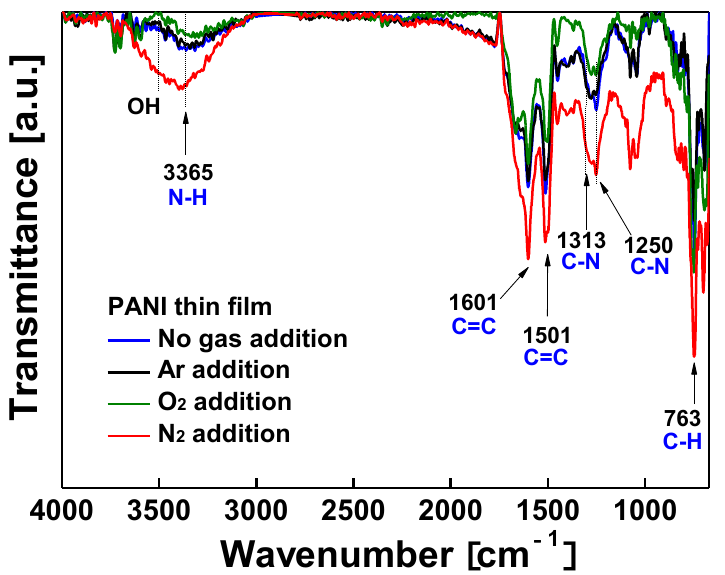
Figure 6. 2D and 3D AFM images with the roughness of PANI films prepared ( a ) without auxiliary gas, ( b ) with the addition of Ar, ( c ) O 2 , and ( d ) N 2 .